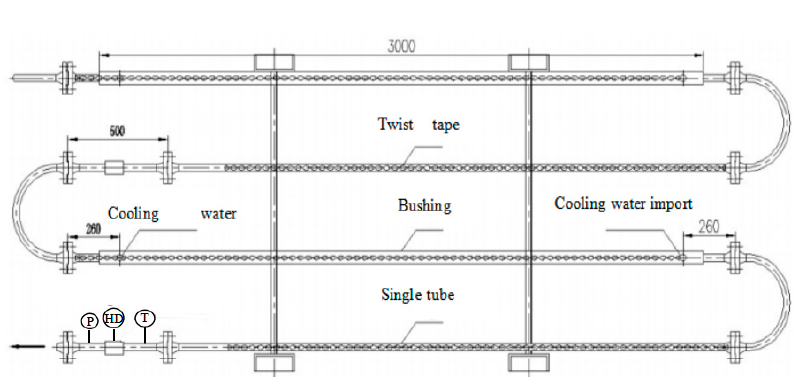
Figure 5. Schematic diagram of the hydrates formation unit.